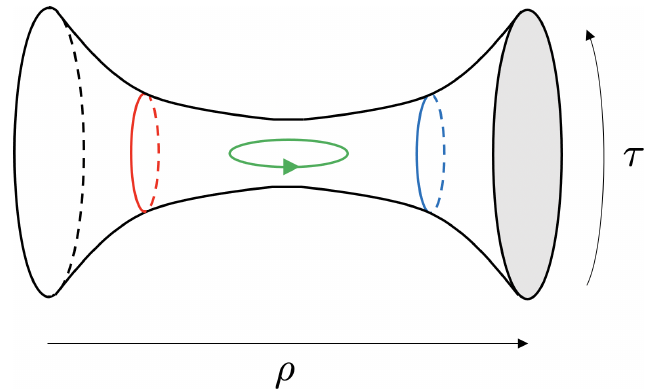
Figure 5 . A visual summary of the two brane instantons found in this section. The circle is the Euclidean time direction, and we have suppressed the other directions. The blue/red pair wrapping the time circle are the D 3 − D 3 brane pair at constant ρ from subsection 7.1. For the S 1 × S 3 wormhole, this arrangement is a saddle of probe 3-branes and, if b > b c , placing the branes there lowers the wormhole action. To the left of the D 3 -brane, and to the right of the D 3 -brane, there are N units of 5-form flux, while in between there are N − 1 . The green circle is the instanton from subsection 7.2. This configuration leads to an instanton correction to the wormhole amplitude, again for b > b c . If we analytically continued τ to real time then this instanton leads to a dynamical instability of the wormhole to the production of a 3-brane